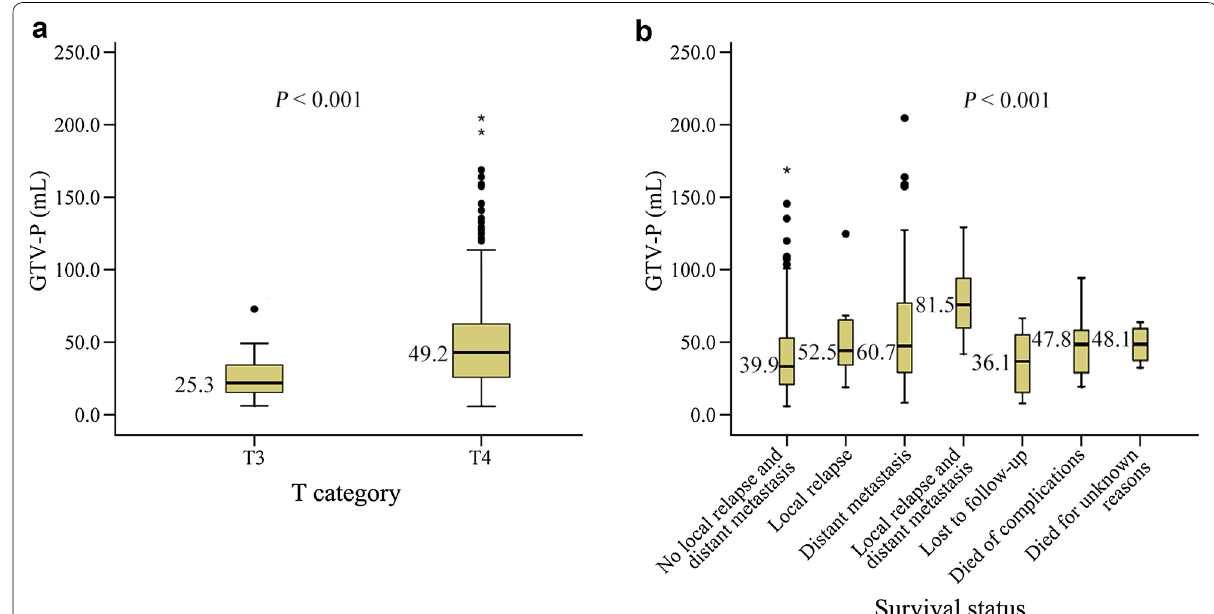
Fig. 2 Box plot of GTV‑P in patients with locally advanced NPC. a GTV‑P of patients with T3 and T4 tumors. The 7th American Joint Committee on Cancer (AJCC) staging system was used for T classification. b GTV‑P of patients with different survival